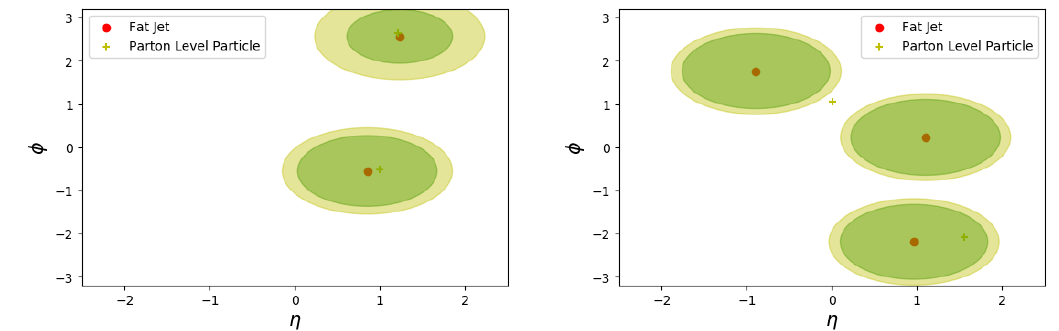
Figure 5 . pp ! t (cid:22) t (cid:12)nal states. The red dot is the center of the identi(cid:12)ed jet, the yellow cross is the parton-level top, the yellow region is the clustering cone R = 1 : 0, and the green region is the actual extent of the jet. In the left panel two top jets are identi(cid:12)ed, while in the right panel only one top jet